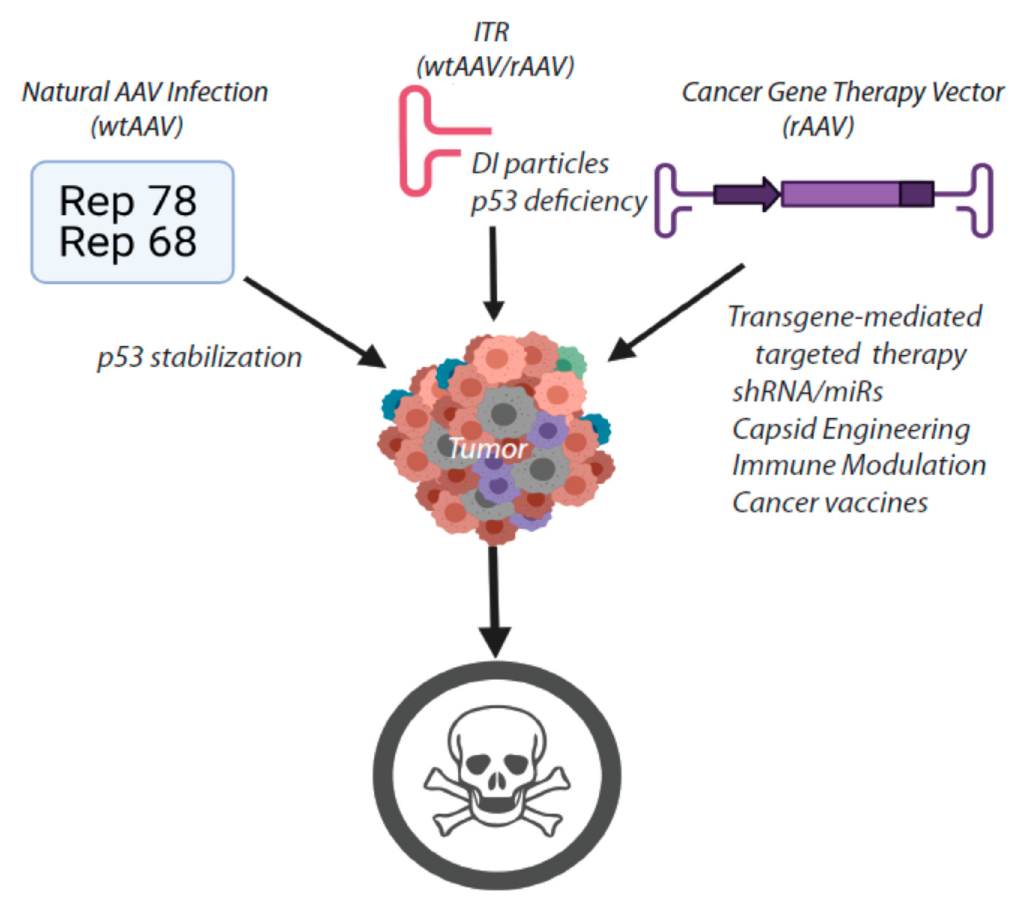
Figure 2. Summary of the potential attributes of AAV for cancer gene therapy.